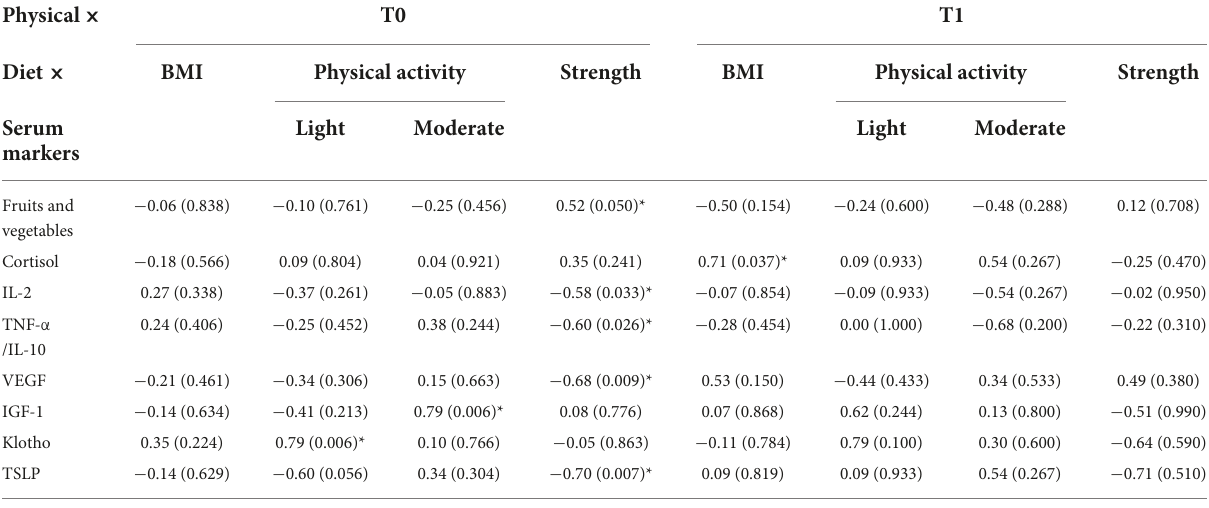
TABLE 3 Associations of Body Mass Index (BMI), physical activity, strength, fruit and vegetables, and serum markers by Spearman correlations analysis before (T0) and 6 months of physical distancing (T1). Physical × T0 T1 Diet × BMI Physical activity Strength BMI Physical activity Strength Serum Light Moderate Light Moderate markers Fruits and vegetables